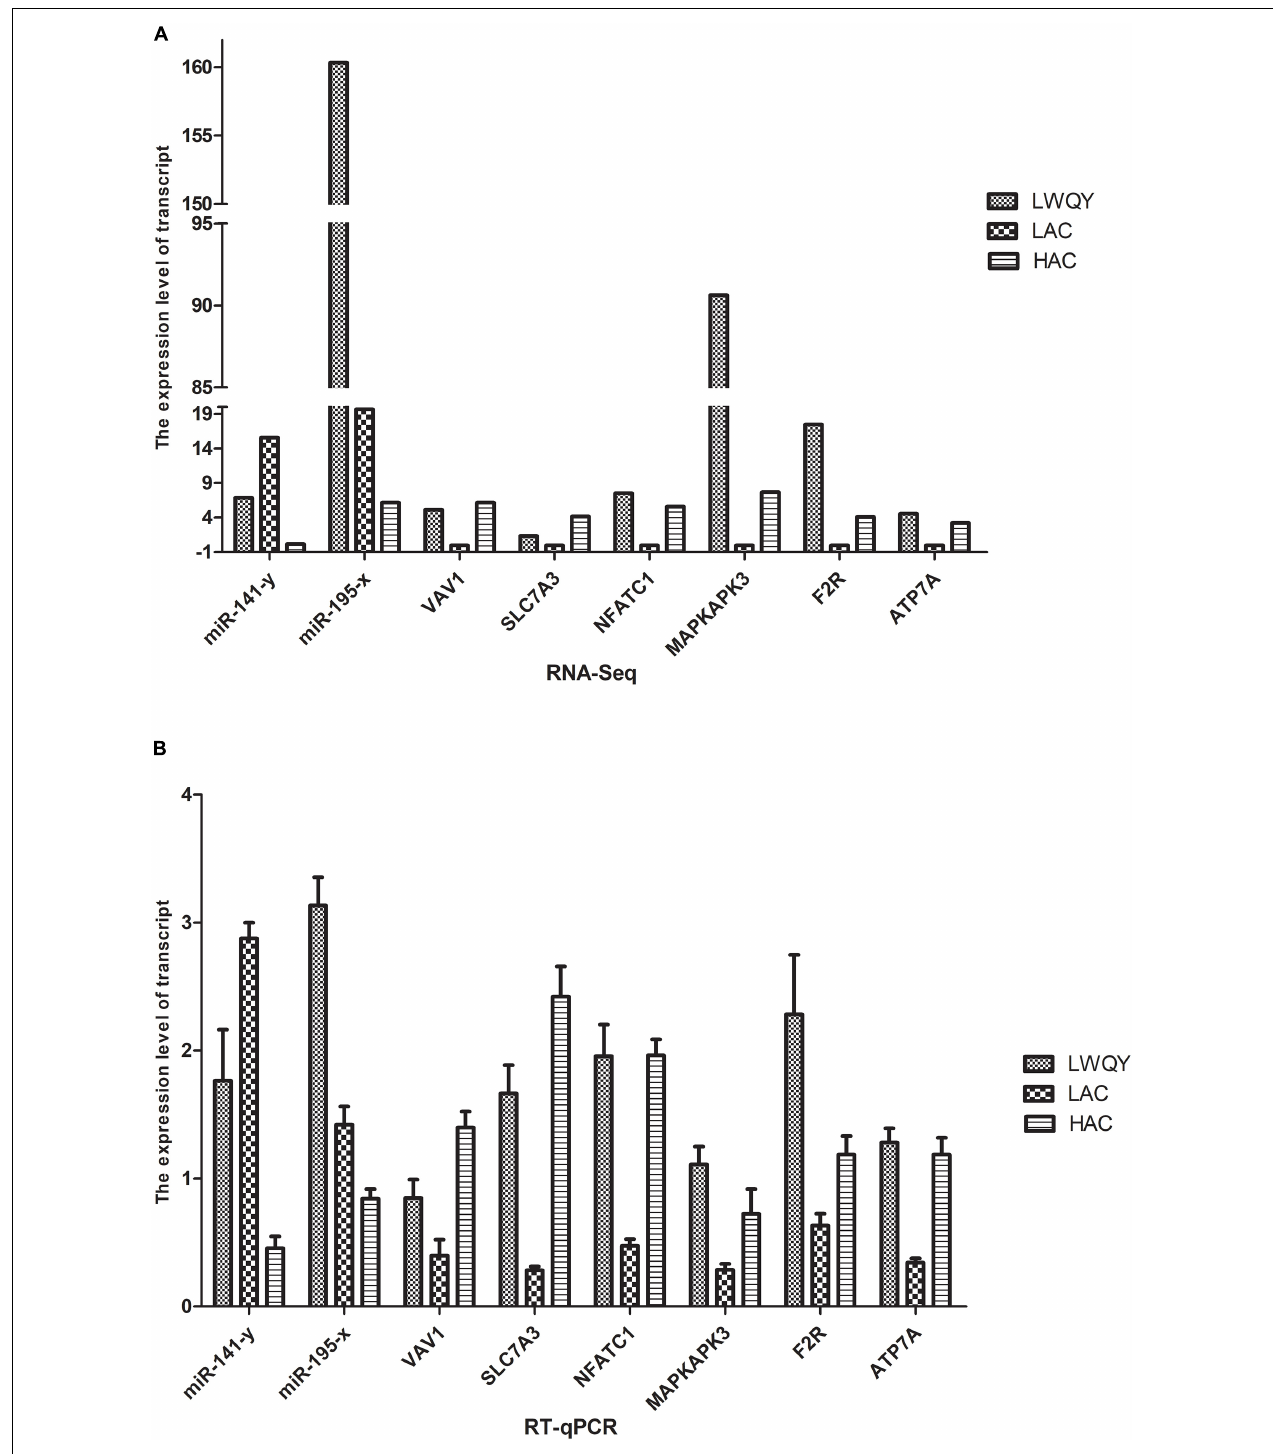
FIGURE 6 | Validation of differentially expressed genes. (A) The RNA-seq results of the transcripts. (B) the RT-qPCR results of the transcripts.